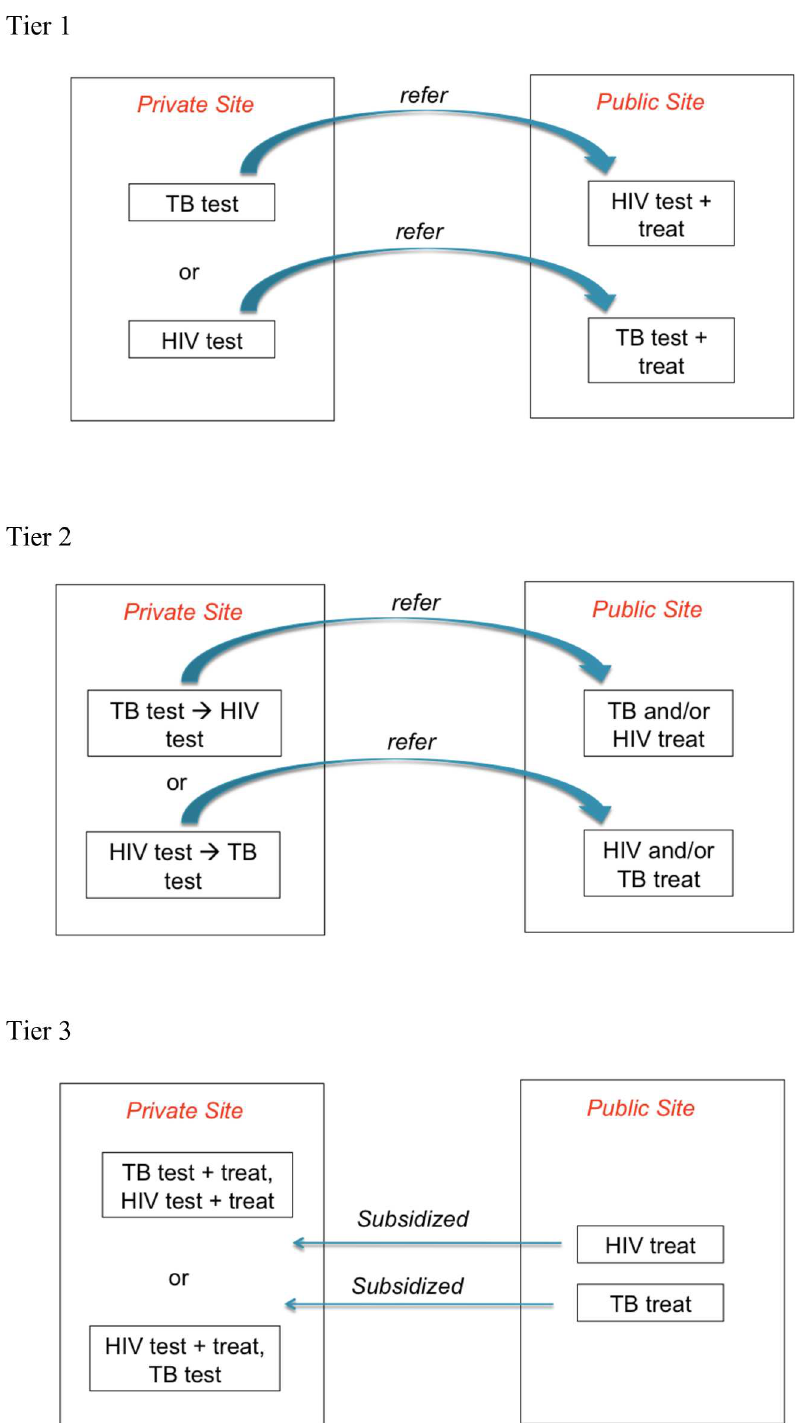
Fig 1. Relationships between private for-profit and public-sector providers. Tier 1 is the most basic model of public-private mixed service delivery. If patients tested positive for HIV or TB and can then be tested for TB or HIV at the same facility, then the health center is classified as a Tier 2 integrated health center. Health centers that can test for both TB and HIV and provide government subsidized medication for both conditions (effectively integrating public health service delivery in a private health setting) are classified as considered a Tier 3 integrated health centers.